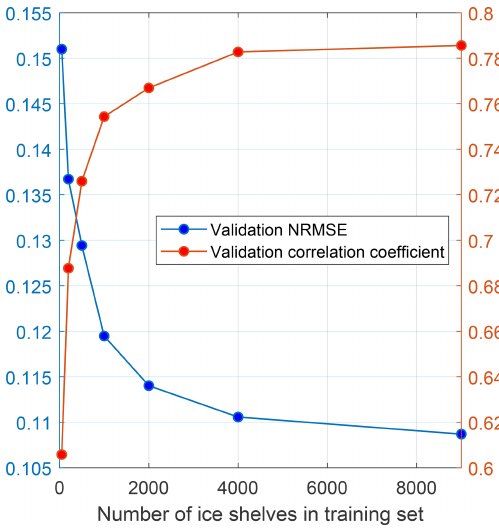
Figure B2. Change in NRMSE and correlation coefficient for MELTNET with respect to NEMO melt rates as a function of chang- ing the size of the training set.